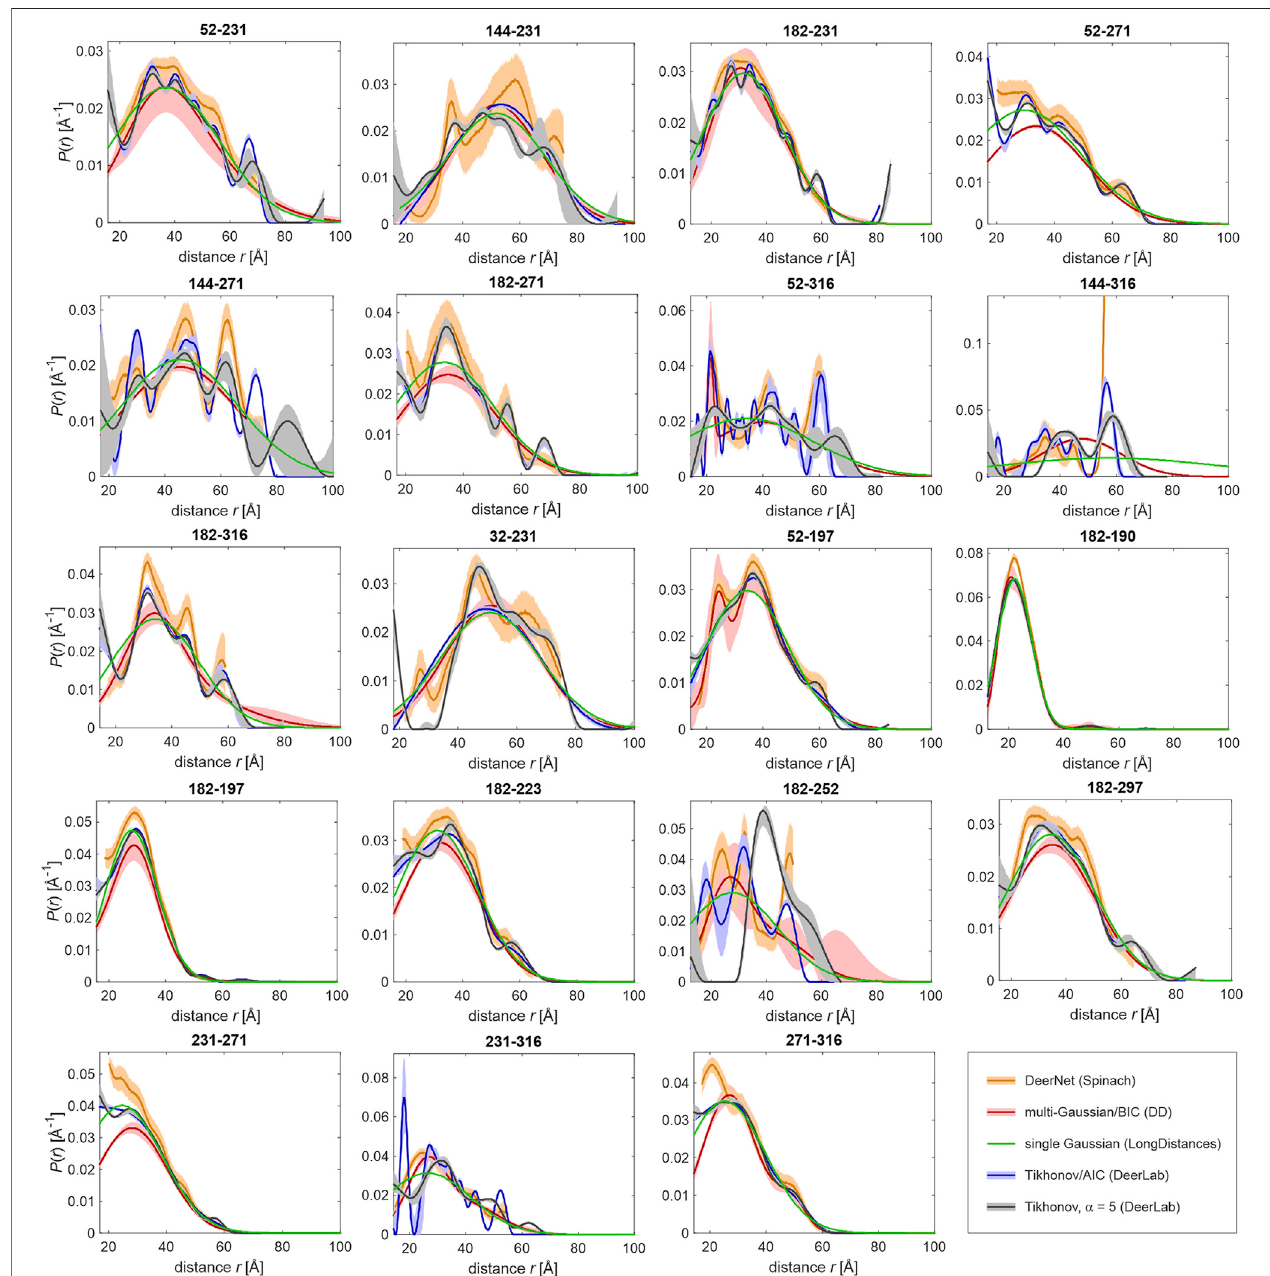
FIGURE 4 | Distance distributions computed by different approaches from primary DEER data for 19 pairs of MTS-labelled sites. The approaches are DeerNet in Spinach 2.5.5446 (orange), multi-Gaussian fi t with the number of Gaussians determined by the Bayesian information criterion (BIC) in DD (red), single Gaussian fi t including background in LongDistances (green), Tikhonov regularization with regularization parameter α determined by the Akaike information criterion (AIC) in DeerLab 0.8b (blue), and Tikhonov regularization with fi xed α (cid:1) 5 in DeerLab 0.8b (gray/black). Pale areas denote uncertainty bands (50% con fi dence interval for DeerLab, 95% con fi dence interval for DeerNet and